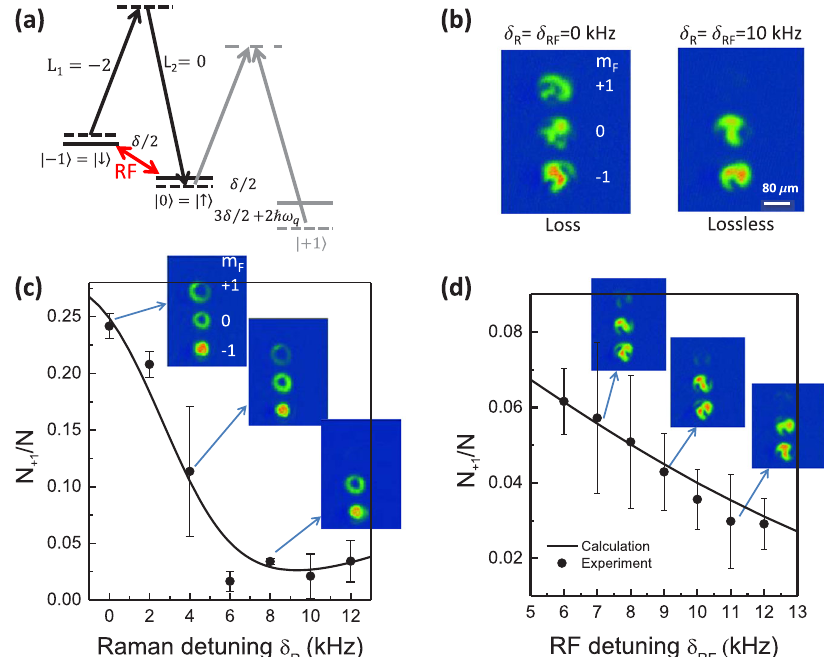
Fig. 2 Preparation of two lossless BSs (the two-photon Raman pulse and the RF pulse). a Energy level diagram. Two laser beams with OAM numbers L 1 = − 2 and L 2 = 0 couple the two spin states "j i ¼ F ¼ 1 ; m F ¼ 0 j i and #j i ¼ F ¼ 1 ; m F ¼ (cid:2) 1 j i . δ is the two-photon detuning. = 2 π × 5.52 kHz is the quadratic Zeeman shift. An RF pulse also couples the two spin states #j i and "j i . b Interference patterns with loss or ω q lossless BSs. Under the resonant condition (left column), δ R = δ RF = 0 kHz, three vortex modes interfere when atoms populate three spin states with loss BSs. Choosing an appropriate detuning (right column), δ R = δ RF = 10 kHz, two vortex modes interfere when atoms only populate two spin states with lossless BSs. c Atom ratio N + 1 / N versus the Raman detuning δ R . N is the total atom number and N + 1 is the atom number in the spin state m F ¼ 1 j i . The insets show exemplary atomic images with δ R = 0, 4, 8 kHz. d Atom ratio N + 1 / N versus the RF detuning δ RF . δ R = 10 kHz. The insets show exemplary atomic images with δ RF = 7, 9, 11 kHz. The solid curve is the theoretical calculation on three-level atoms coupled with a Raman or RF pulse. The error bar is the stand deviation of several